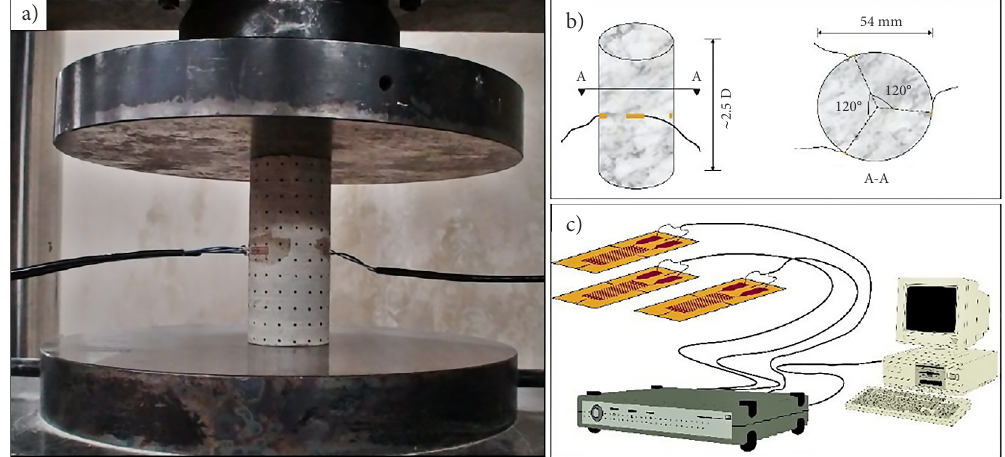
Figure 4. (a) Sample placed between two steel plates of compressive strength test machine; (b) position of three strain gauges around the sample to measure lateral strain; (c) display the connection of strain gauges to the